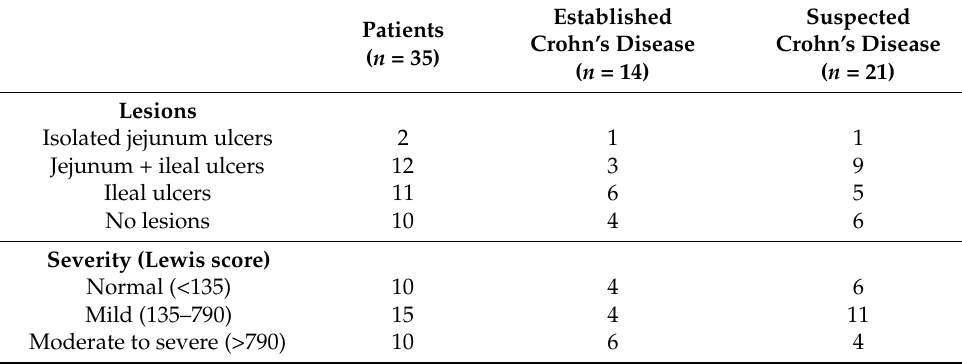
Table 2. Small bowel capsule endoscopy findings and Lewis score.